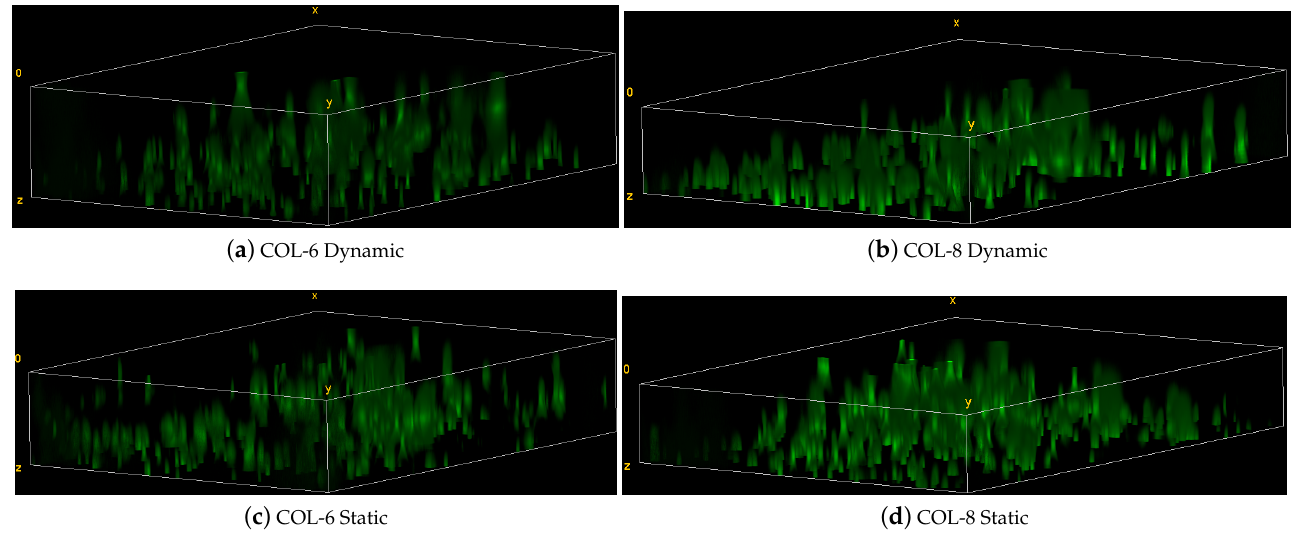
Figure 13. Representative 3D images of z-stacks in the static and dynamic culture of COL-6 and COL-8